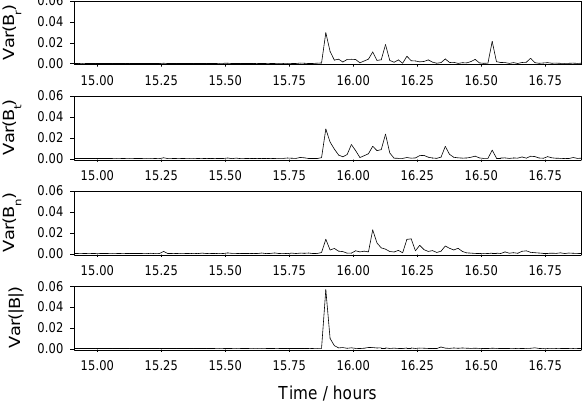
Fig. 8. Magnetic field variance in 3 components and magnitude (4 panels) using bins of 60s of data for shock on day 296, 1997. The three components are in the standard heliospheric r, t, n coordinate system.